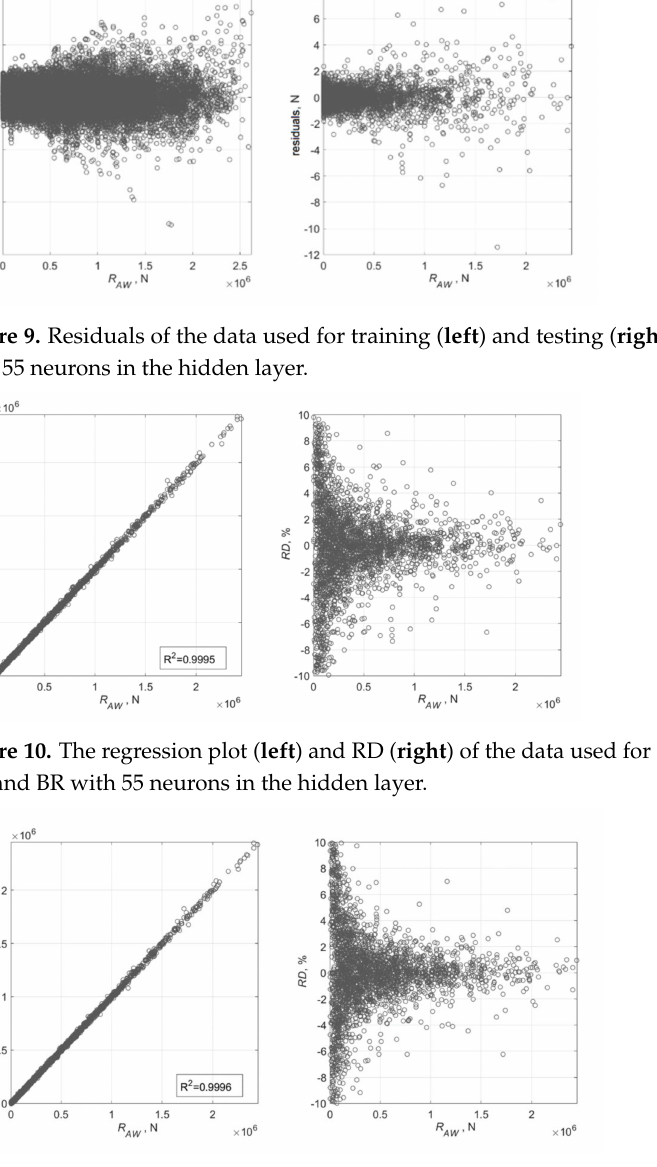
Figure 11. The regression plot ( left ) and RD ( right ) of the data used for the testing of the ANN with LM and BR with 65 neurons in the hidden